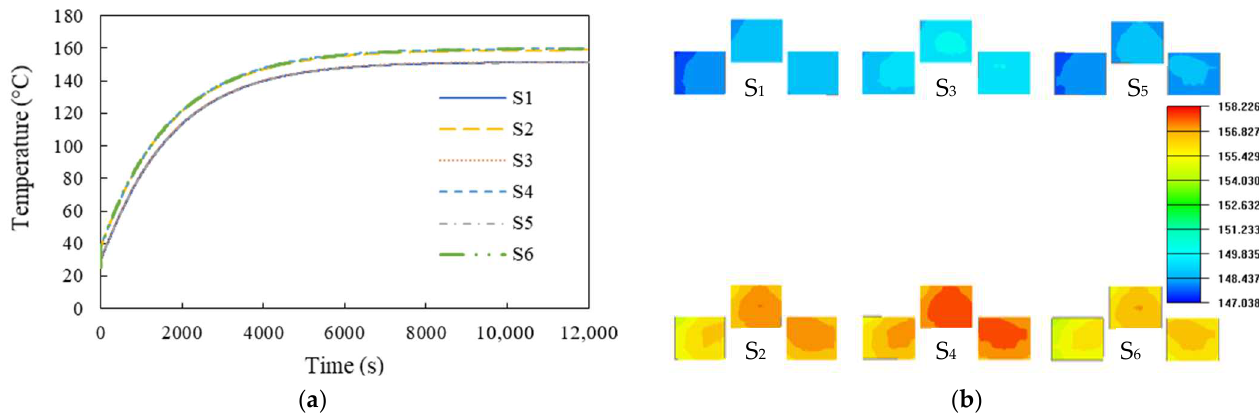
Figure 10. Thermal behavior of the six inverter switches: ( a ) transient maximum junction temperature profiles and ( b ) temperature distribution in the MOSFET chips.